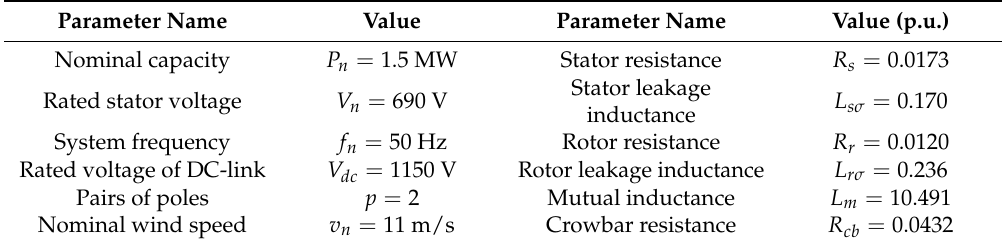
Table A3. The parameters of